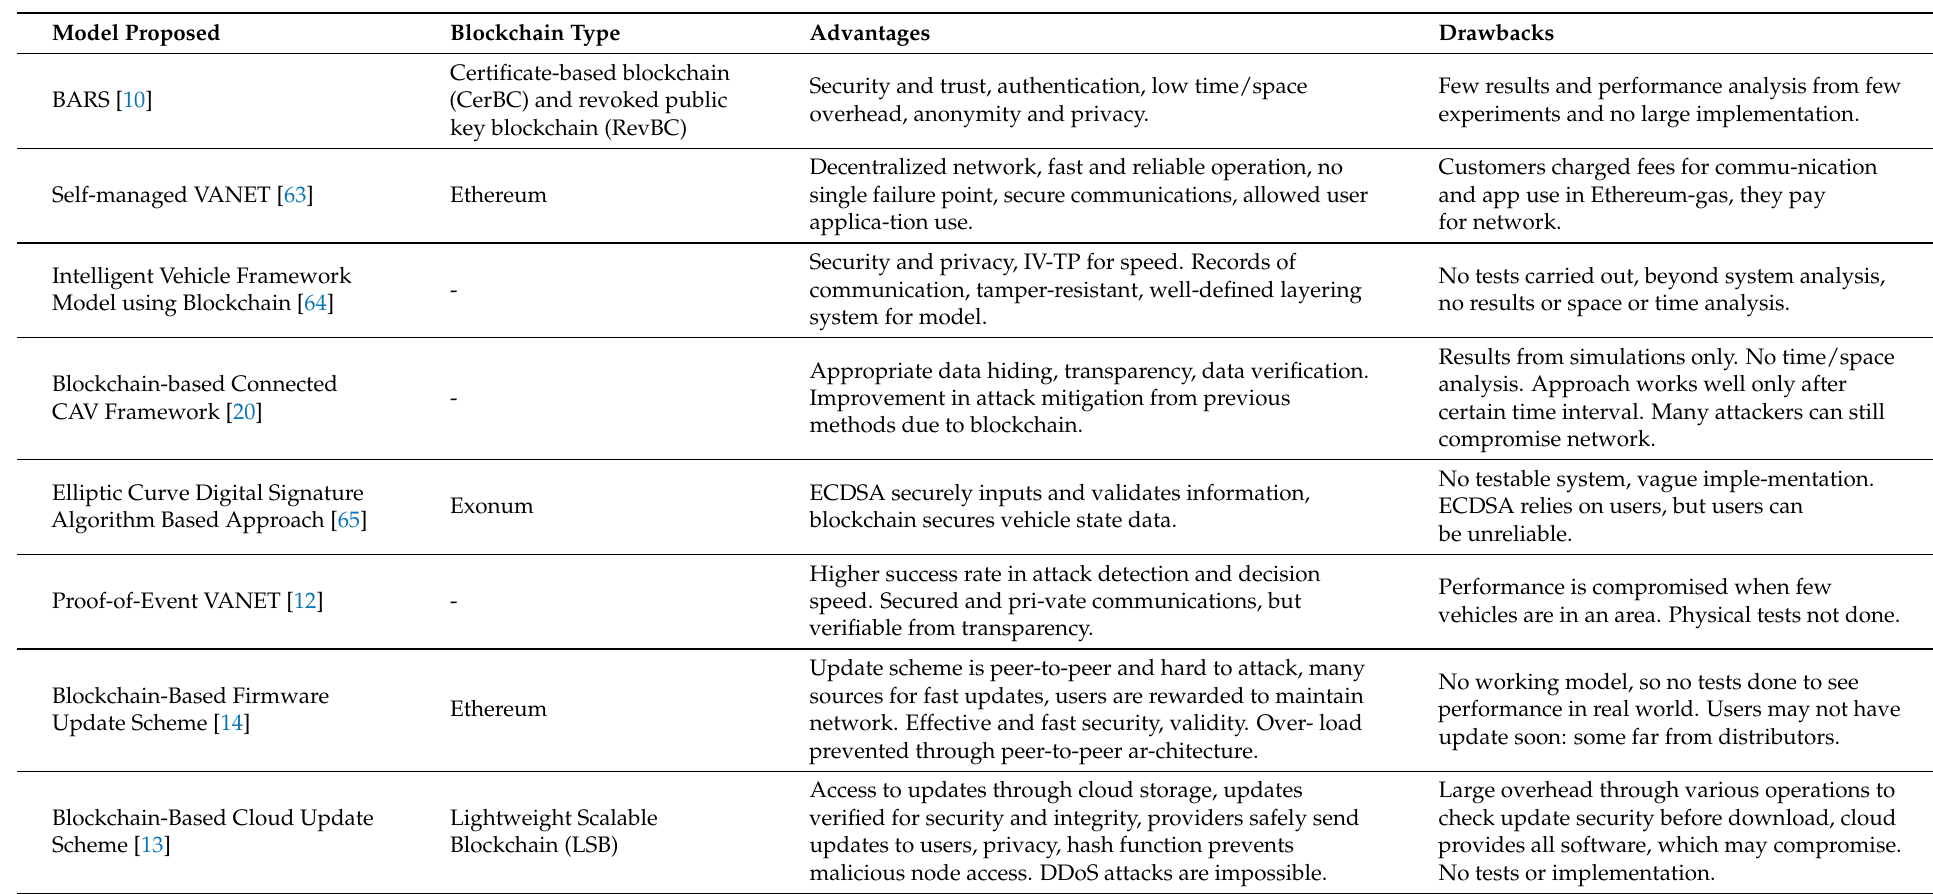
Table 3. A comparison of selected security methods in terms of advantages, drawbacks, and type of blockchain